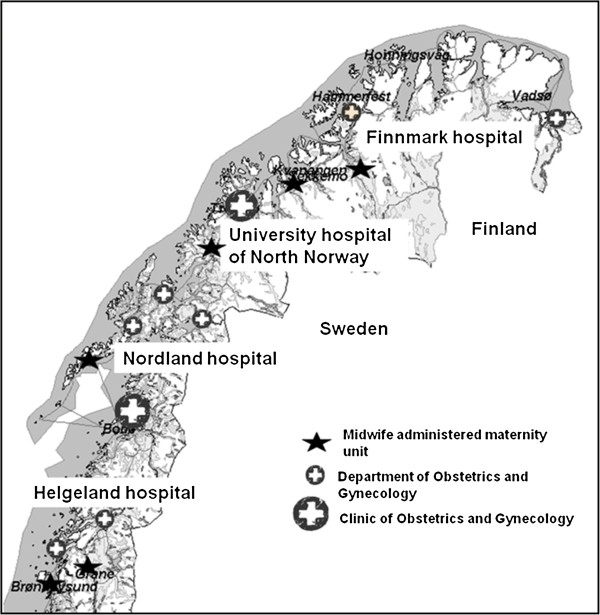
The figure shows the midwife administered maternity units and the departments and clinics of obstetrics and gynaecology and the four hospital trusts in northern Norway.